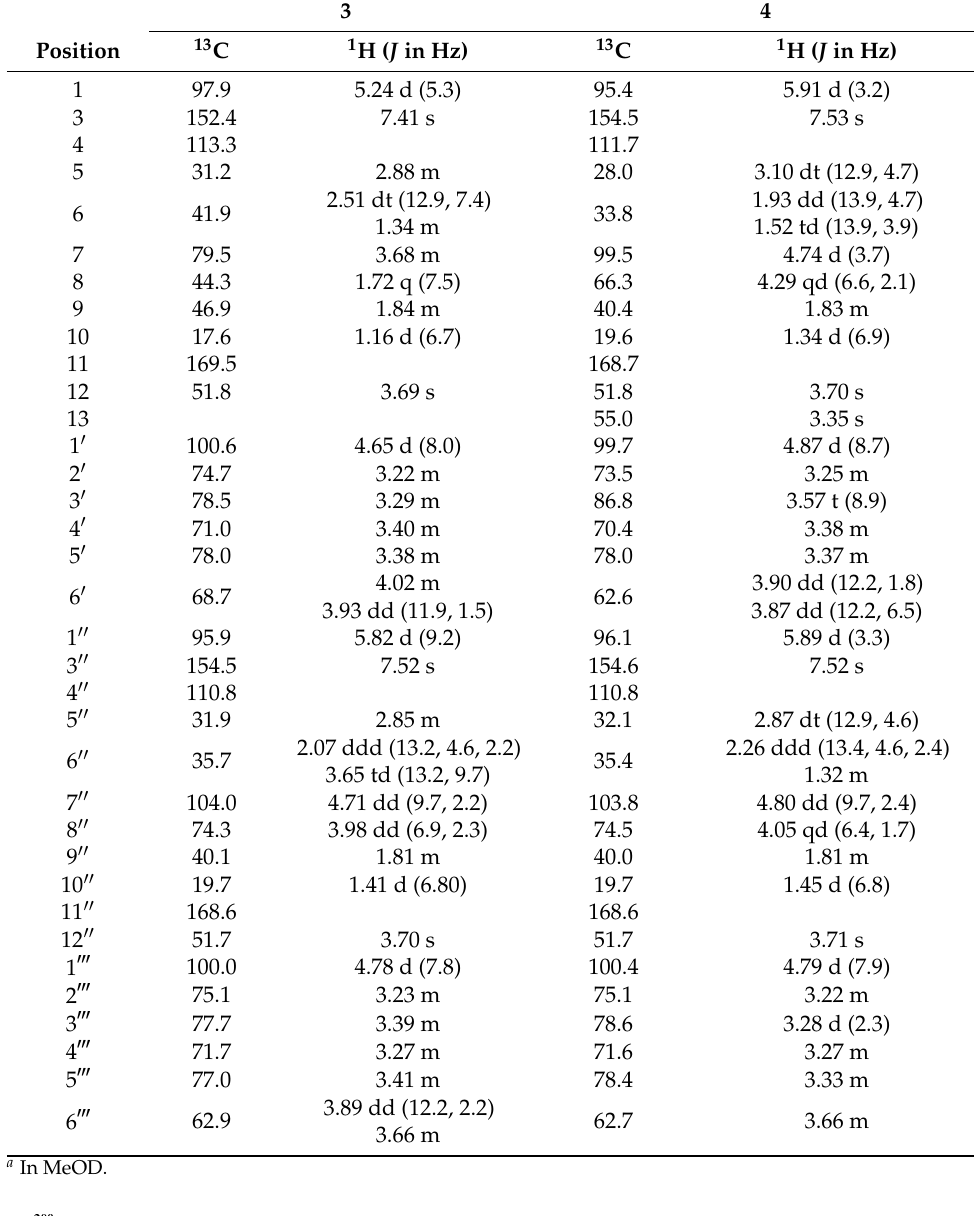
Table 2. 1 H NMR (500 MHz) and 13 C NMR (125 MHz) data ( δ in ppm, J in Hz) for compounds 3 – 4 a .